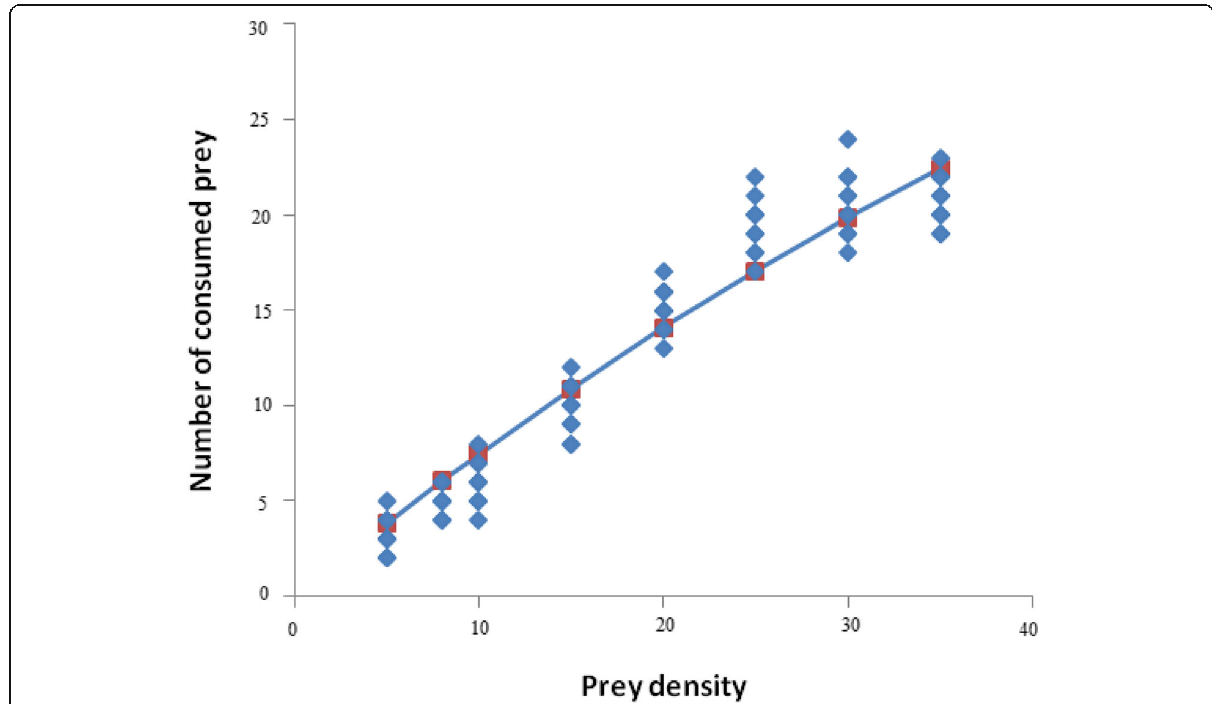
Fig. 1 Mean number of Bemisia tabaci eggs preyed upon by females of Orius albidipennis in 24 h as a function of egg density